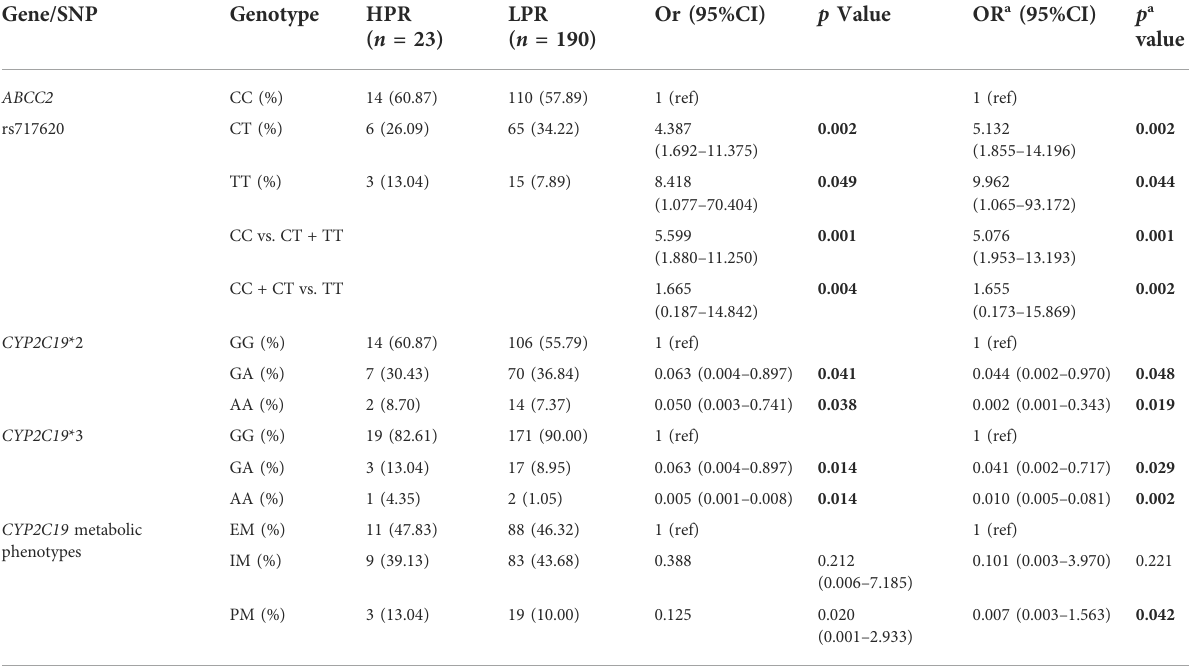
TABLE 3 Association between ABCC2 and CYP2C19 SNPs and clopidogrel hyperreactivity in 213 patients based on multivariate logistic regression analysis.